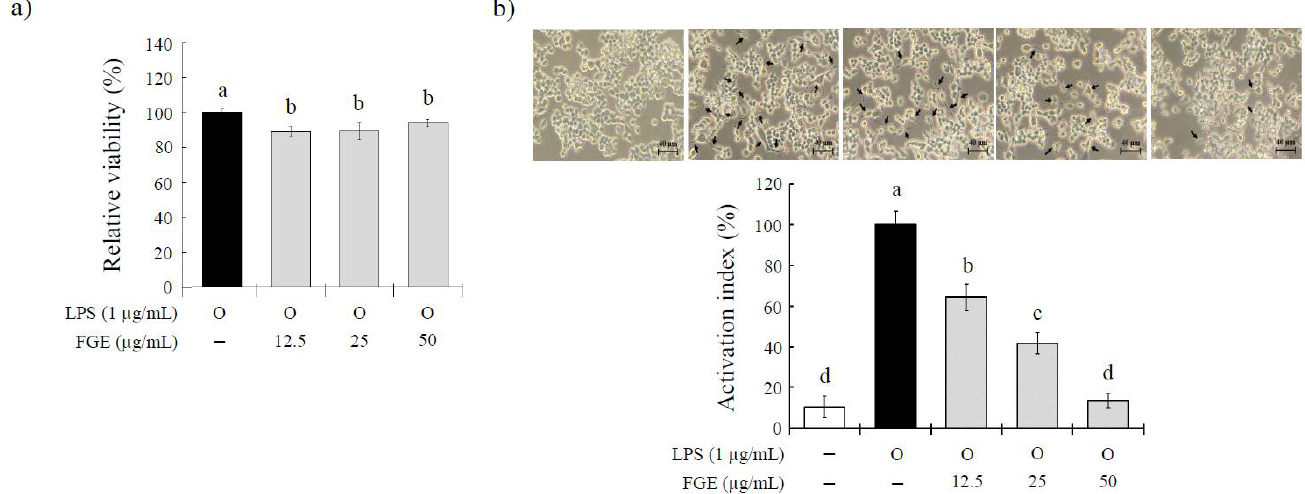
Figure 1. Effect of Filipendula glaberrima Nakai extract on the morphological changes and cytotoxicity on LPS-treated RAW 264.7 macrophages. RAW 264.7 cells were treated with each sample for 30 min, and then LPS (1 µg/mL) was stimulated for a further 24 h. ( a ) The cell viability was measured using a commercial MTT assay. ( b ) The cell morphology was photographed using a microscope, and dendritic-like cells (black arrows) were counted to calculate the activation index of the cells. The results are expressed as the mean ± S.D. of three independent tests in triplicate. Different superscripts mean a significant difference among groups ( p < 0.05) based on one-way ANOVA and Duncan’s multiple range test. LPS, lipopolysaccharide; FGE, ethanol extract of Filipendula glaberrima Nakai.